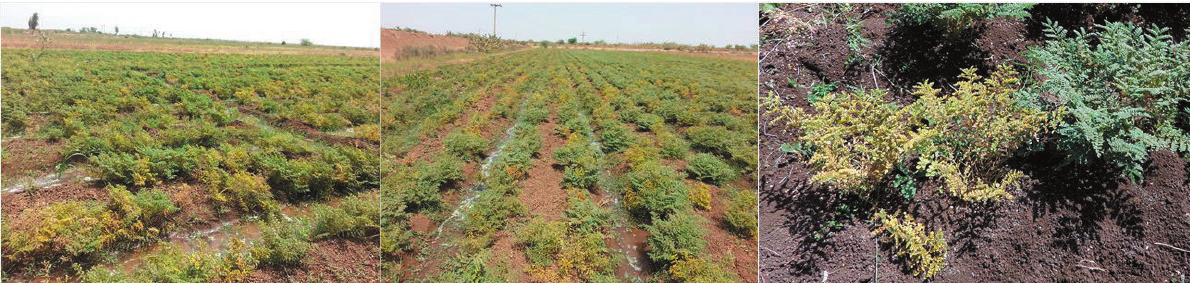
Figure 1. Plants showing yellowing and stunting symptoms in chickpea fields in the Gezira Scheme, Sudan during the 2015 cropping sea-